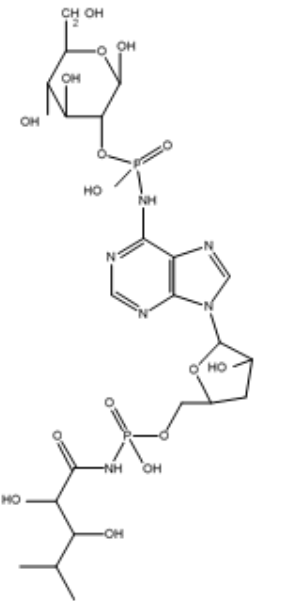
β - d -Glucopyranosyl-form (provided by the late Max Figure 2. Agrocin 84 in N- 6β - D -Glucopyranosyl - form (provided by the late Max Tate). Figure 2. Agrocin 84 in N - 6